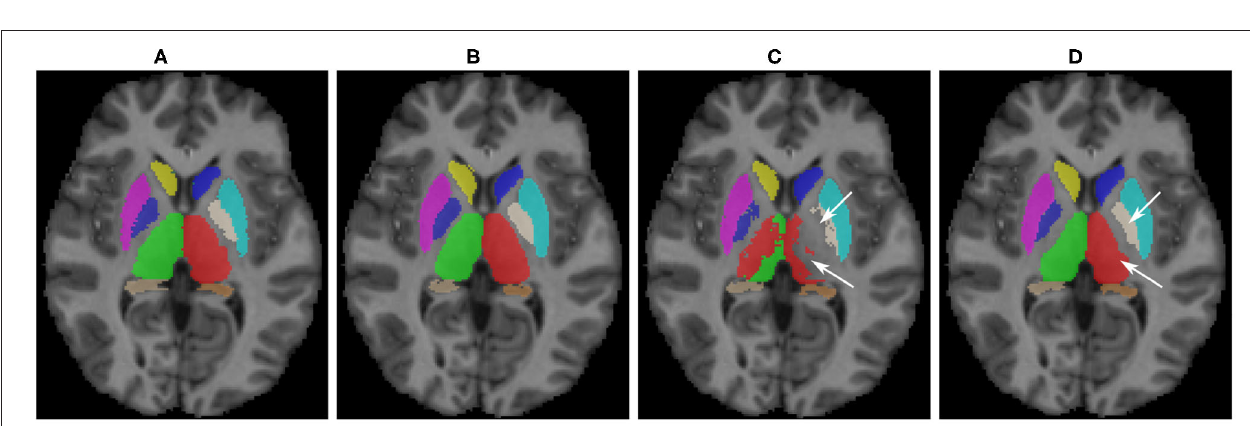
( p = 0.0005), left amygdala ( p = 0.0009), and right